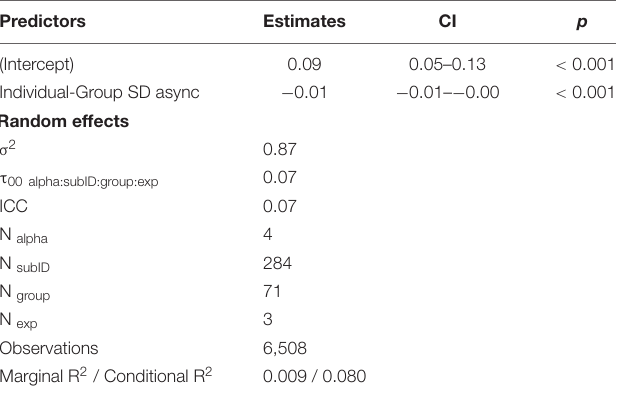
TABLE 5 | Individual groove ratings as a function of SD asynchrony difference from group. Predictors